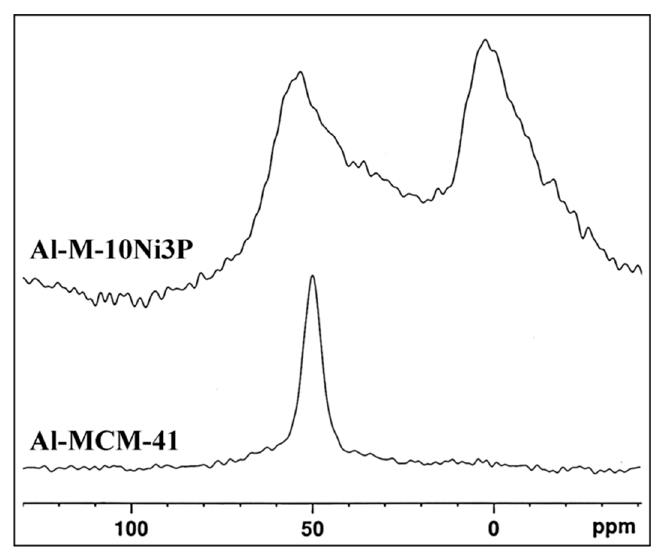
Figure 4. 27 Al MAS-NMR spectra of Al-MCM-41 and Al-M-10Ni3P materials.